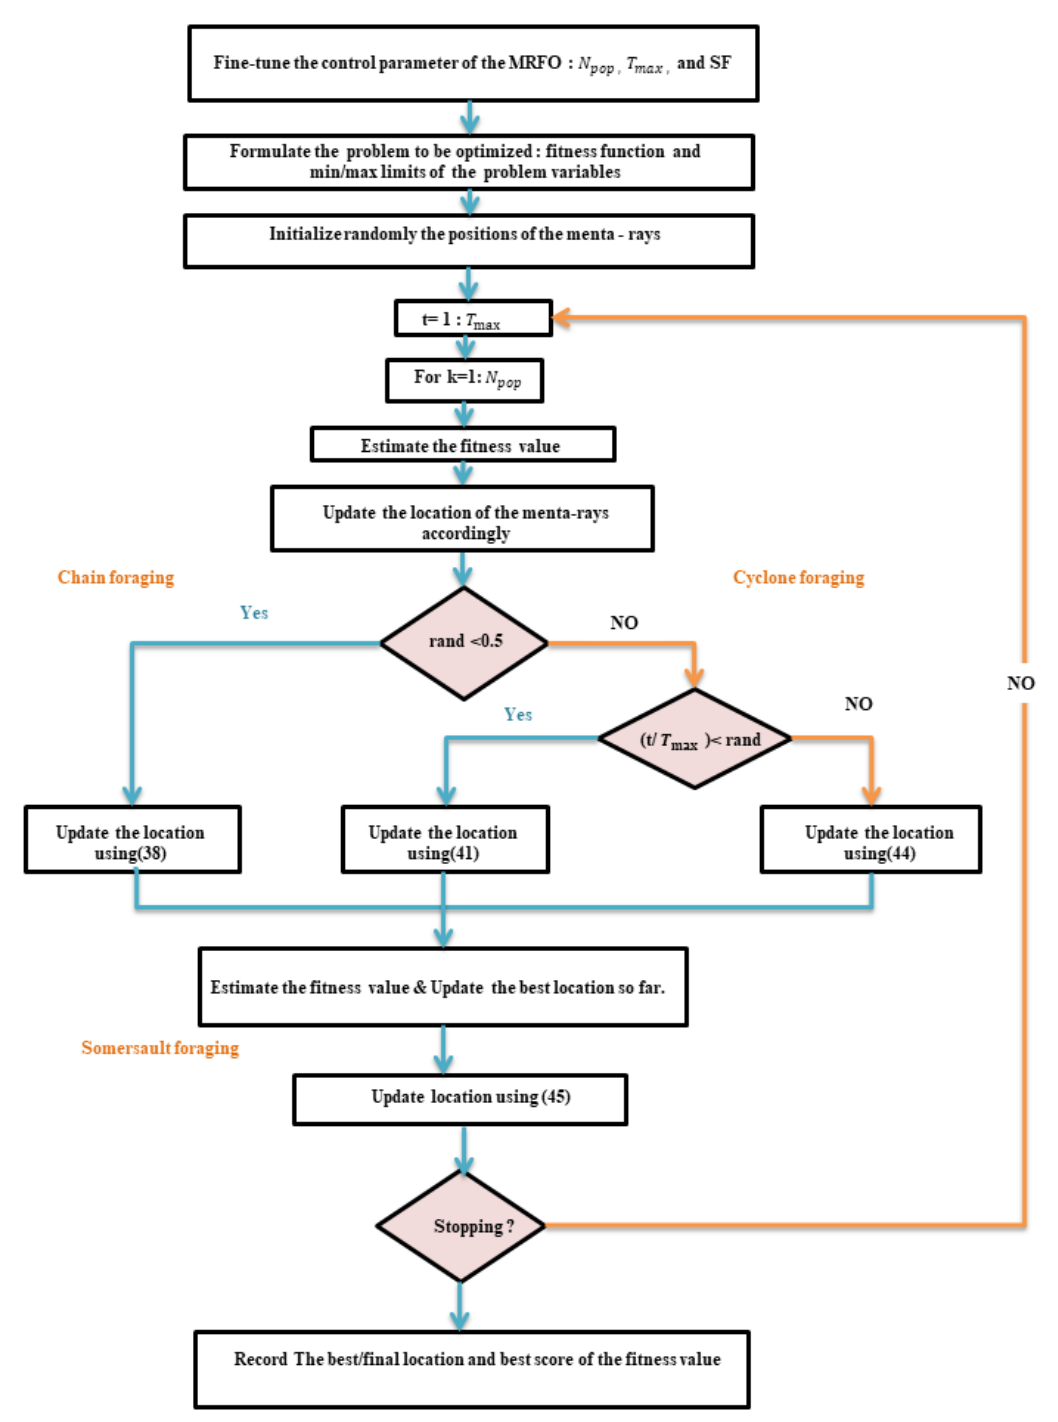
Figure 4. A flow chart of the MRFO.